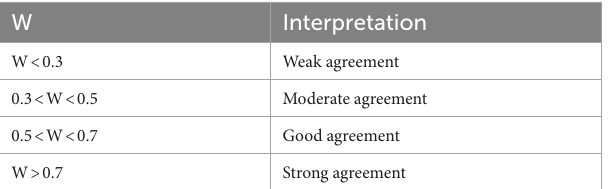
TABLE 4 Kendall’s W (coefficient of concordance), based on Schmidt (1997).